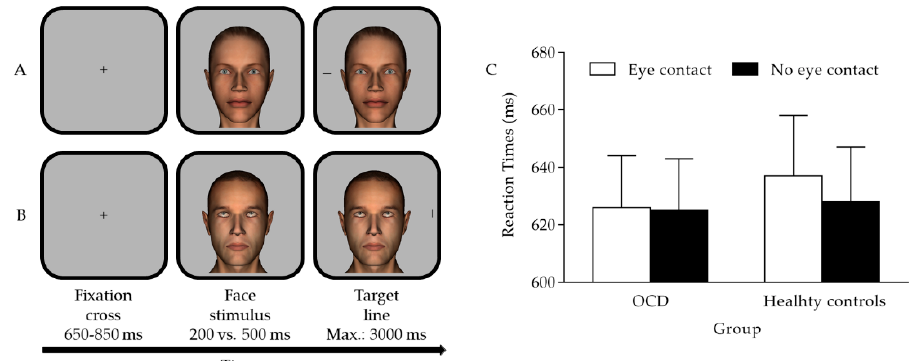
Figure 1. ( A ) depicts the female avatar face with direct gaze (i.e., eye-contact condition) and the horizontal target line appearing leftward; ( B ) depicts the male avatar face with averted gaze (i.e., no-eye-contact condition) and the vertical target line appearing rightward; ( C ) graphical representation of the eye-contact × group interaction in which the mean latencies observed for the eye-contact and the no-eye-contact conditions, within each group, are depicted (error bars are SEM).